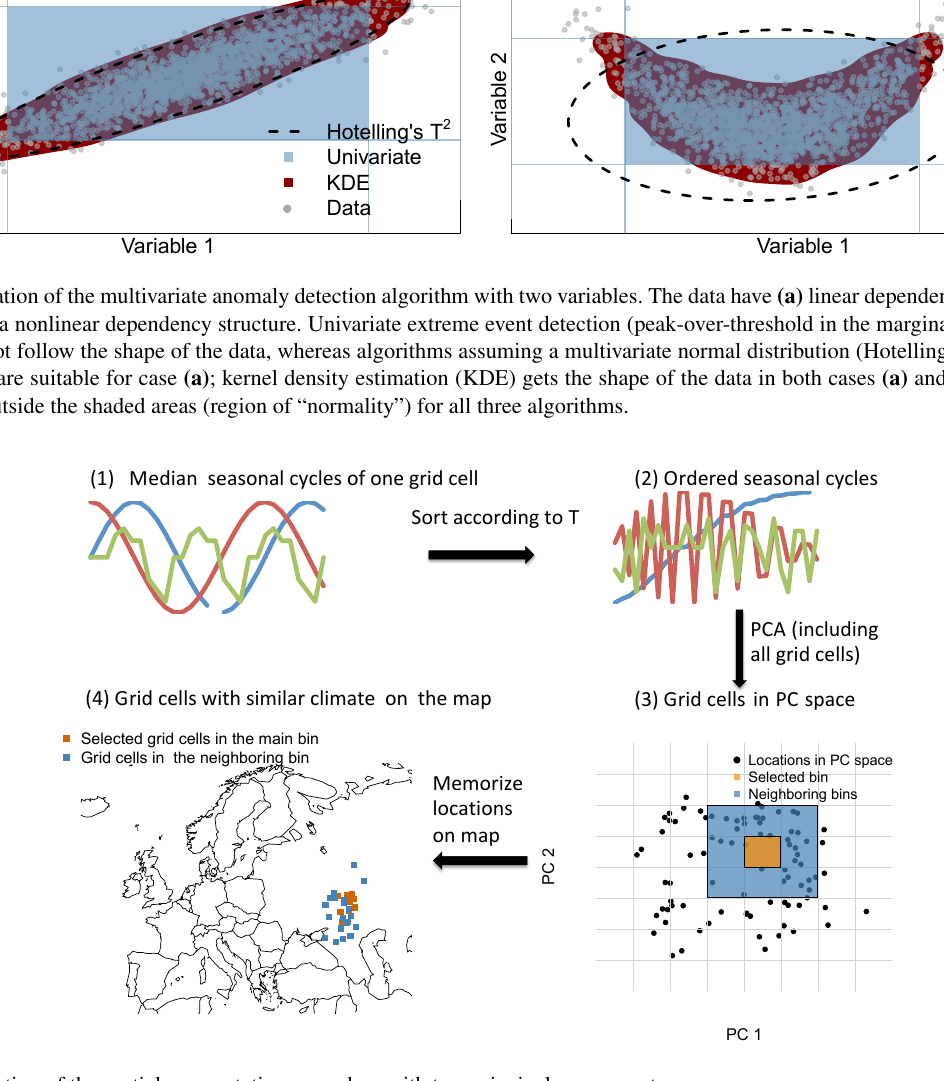
Figure 4. Illustration of the spatial segmentation procedure with two principal